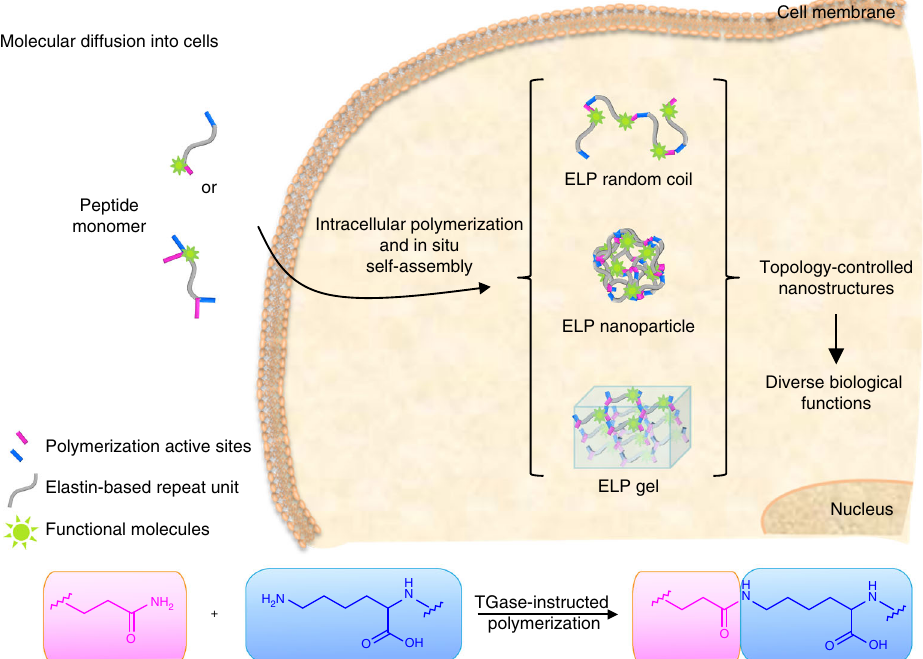
Fig. 1 Schematic illustration of intracellular TGase-catalyzed polymerization and in situ controllable construction of nanostructures. The peptide monomer was composed of an elastin-based repeat unit, one-pair or two-pairs polymerization active sites, and a functional molecule. The TGase-instructed polymerization was performed via formation of isopeptide bond between the side chains of glutamine and lysine. Peptide monomers diffused into cells, and then polymerized intracellularly to form topology-controlled 1D elastin-like polypeptide (ELP) random coil, 3D ELP nanoparticle, and 3D ELP gel. These structure-differentiated ELPs exhibited diverse biological